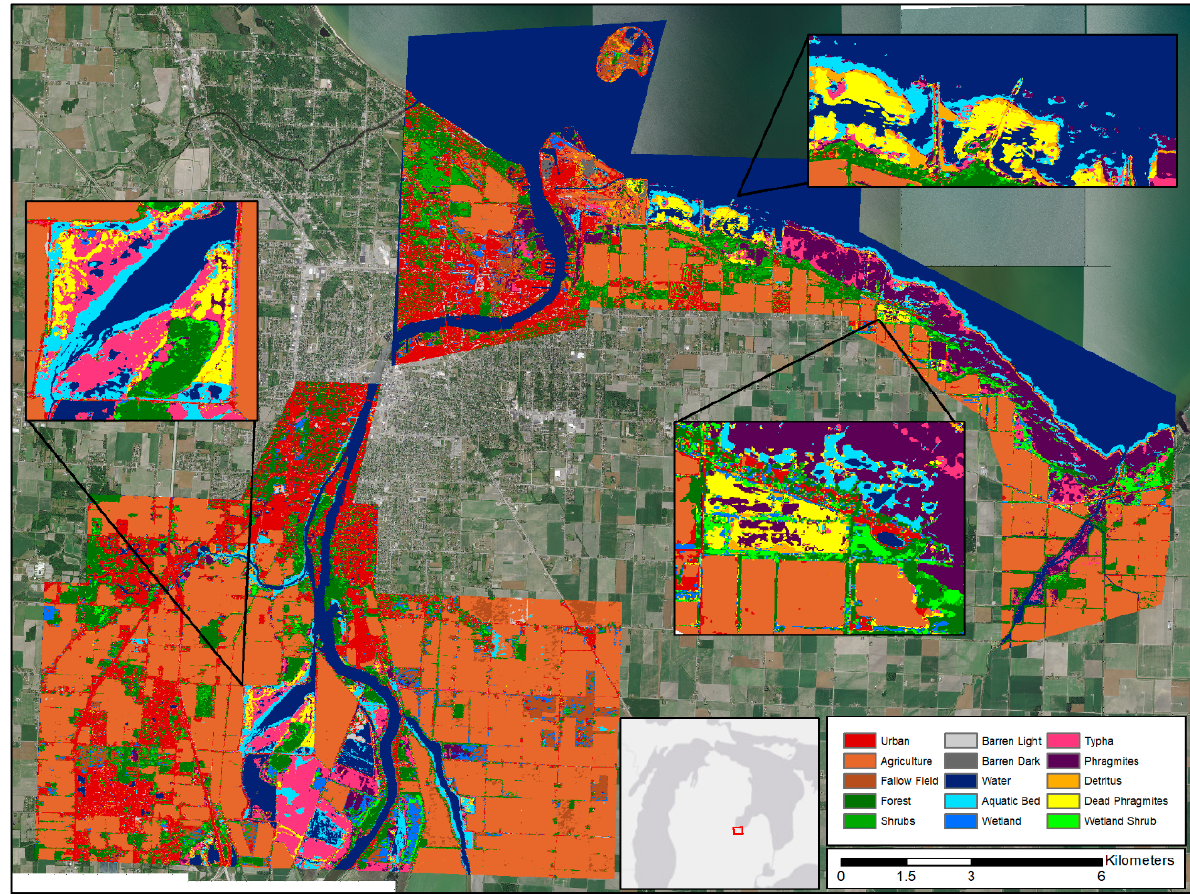
Figure 5. Classified map of Saginaw Bay circa 2018 showing Phragmites (purple), dead Phragmites (yellow), and Typha (pink).